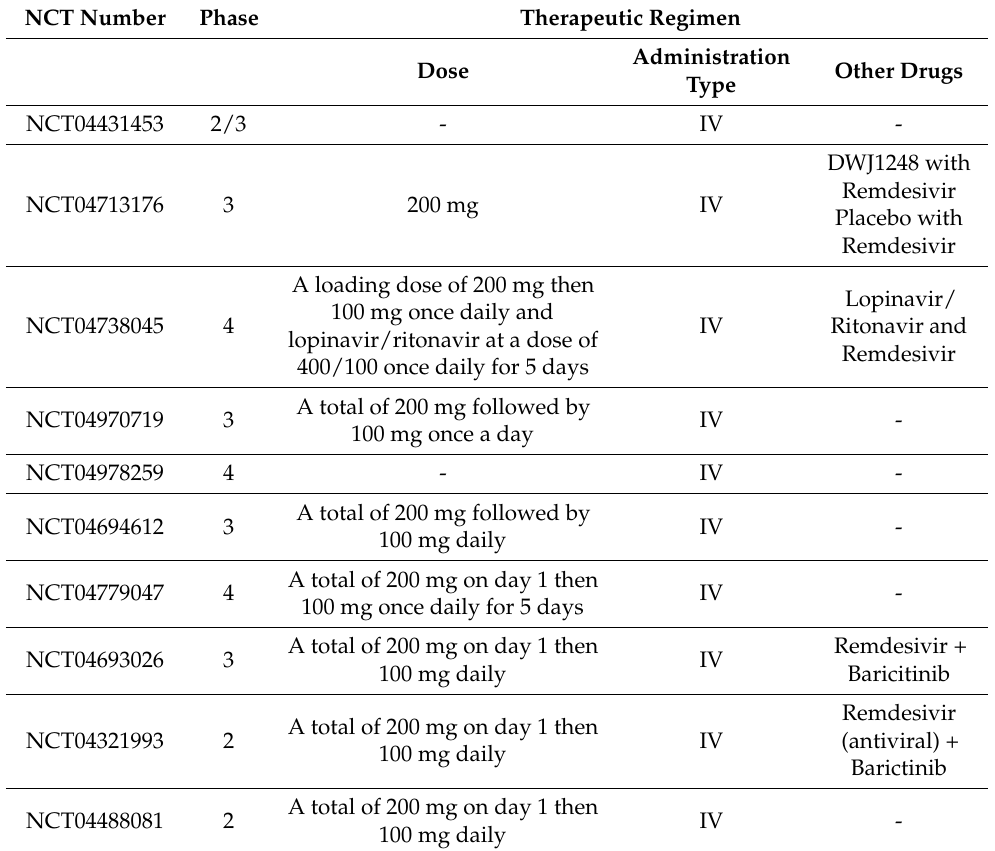
Table 4. Clinical trials using remdesivir for the treatment of COVID-19. Data was collected from clinicaltrials.gov on 28 November 2022. Inclusion criteria: Recruiting, adult population, from